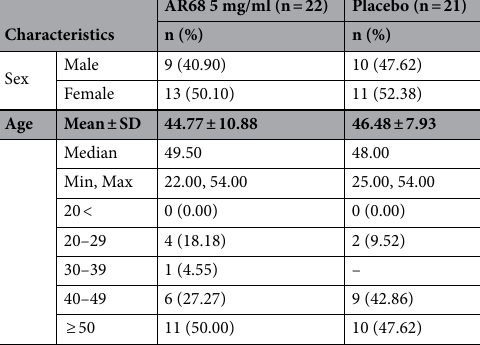
Table 4. Demographic characteristics of the subjects in clinical study II.